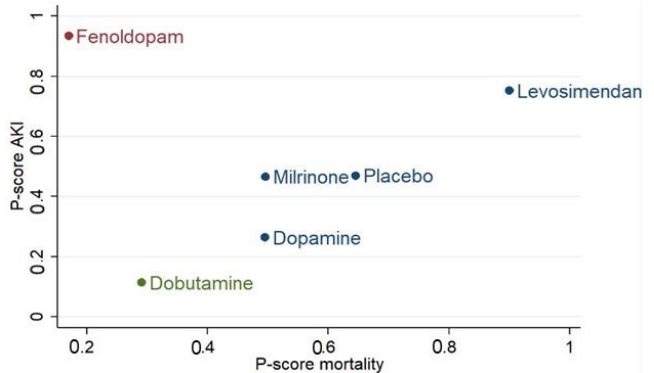
Figure 2. P-scores ranking plot. P-scores ranking plot represents the mortality and the acute kidney injury (AKI) of interventions in a cardiac surgery population. Treatment with better efficacy should be in the upper-right corner of the